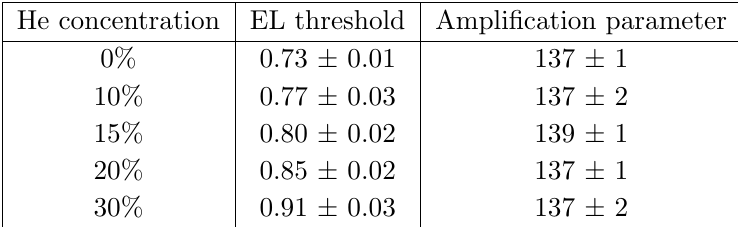
Electroluminescence ampli(cid:12)cation parameter and scintillation threshold obtained